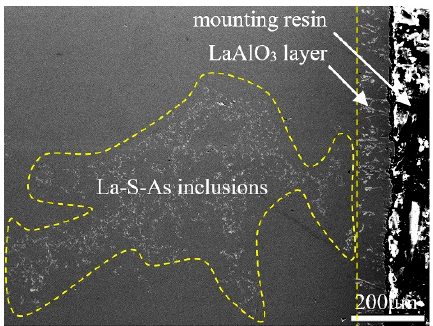
Figure 5. Morphologies of the LaAlO 3 -containing layer at the side surface of the ingot (secondary electron image).